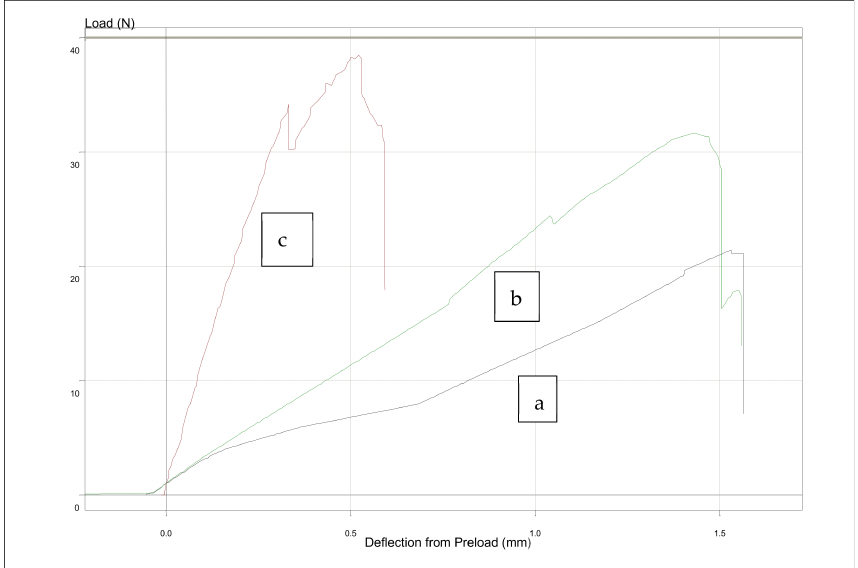
Figure 9. Examples of the load–tooth curves: ( a ) metal retainer (Straight 8), ( b ) metal retainer (Penta one), and ( c ) FRC retainer. All retainers were bonded 1–2 mm from the incisal edge of the teeth, and the force was applied from the buccal direction. Preload from deflection was 0.05